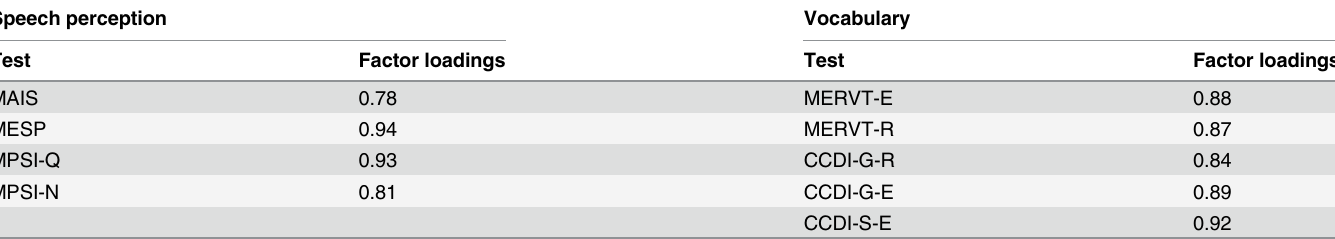
Table 2. Summary of PCA results for speech perception and vocabulary tests (N =